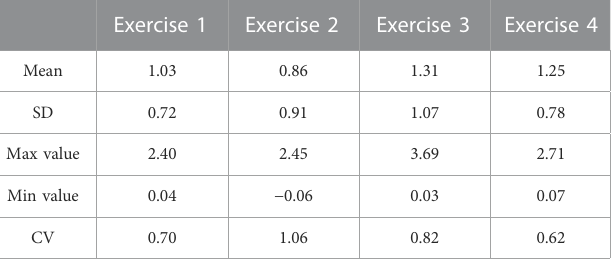
TABLE 3 Δ EE (KgJ/min) during the four exercises in the 14 healthy controls. Exercise 1